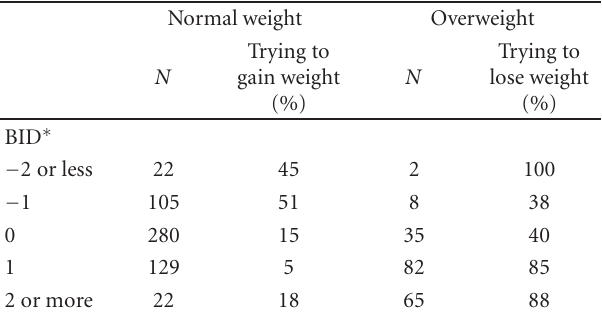
∗ BID: score for current body image minus score for ideal body image.